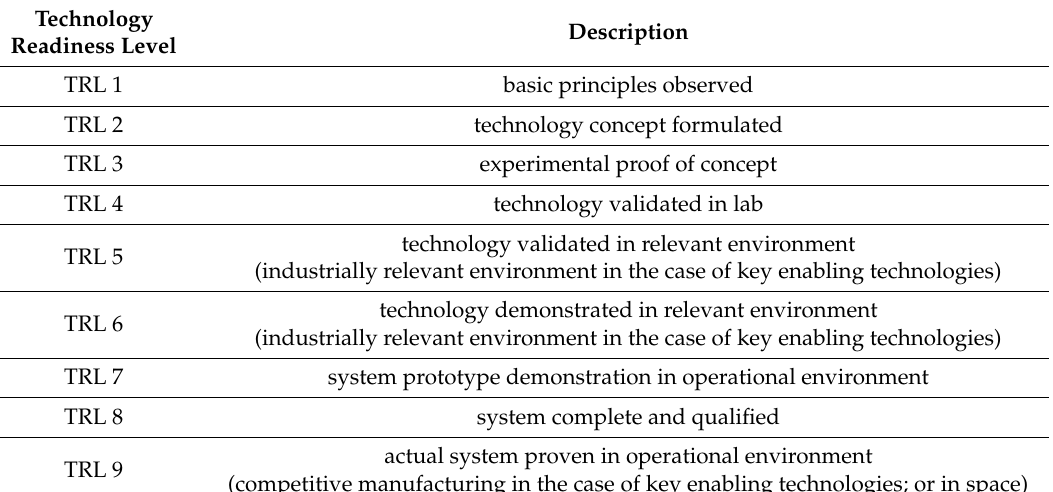
Table A1. Technology readiness levels defined by the European Commission